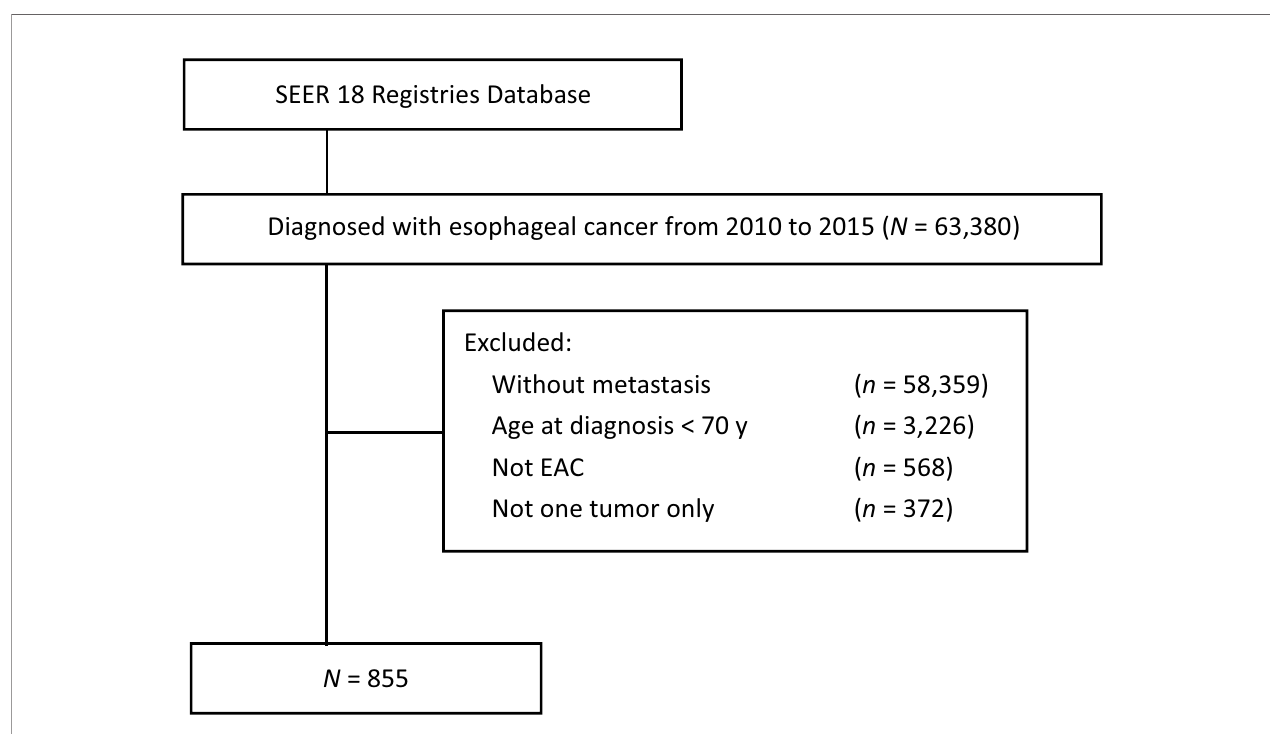
FIGURE 1 | Flowchart of patient selection from SEER database (2010 – 2015). SEER, surveillance, epidemiology and end results; EAC, esophageal